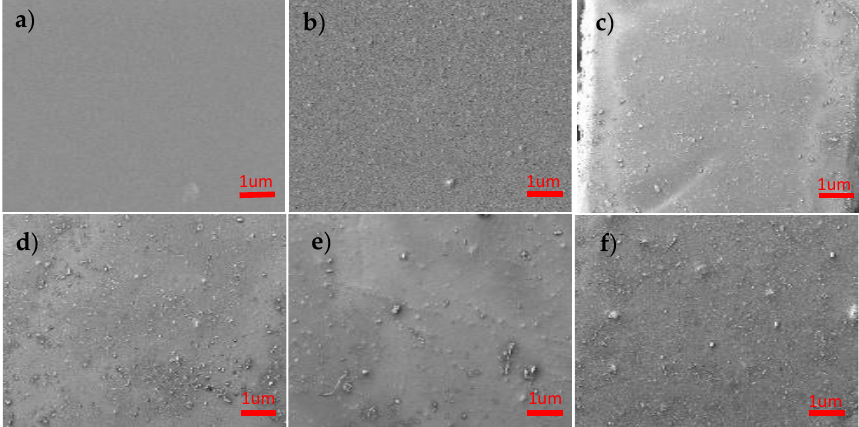
Figure 5. SEM images of surface of membranes (( a ): M0, ( b ): M1, ( c ): M2, ( d ): M3, ( e ): M4, ( f ): M5).